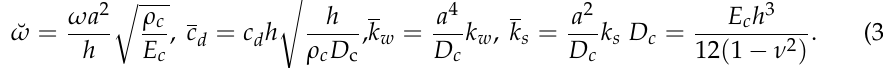
(cid:1)(cid:112) (cid:0) ω a 2 / h ρ m / E m for Al/ZrO 2 FG square